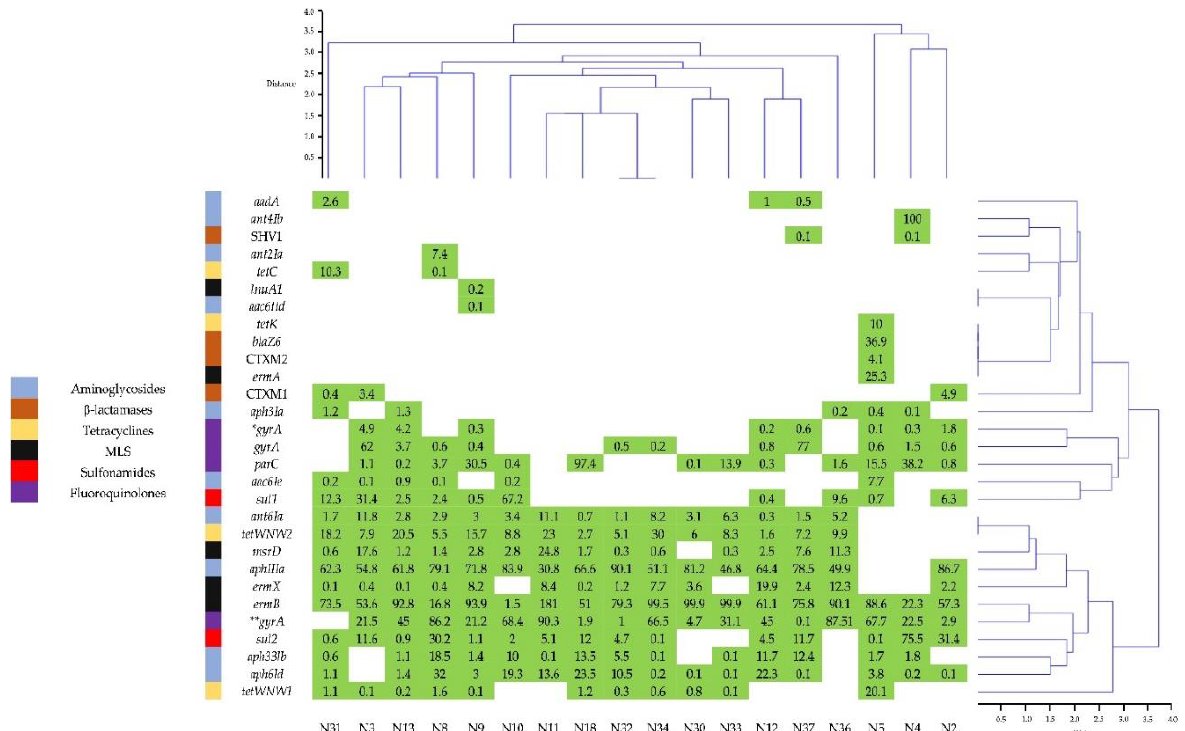
Figure 6. Presence of AMR genes in adolescent fecal samples. The numbers shaded in green indicate the presence of the particular gene, and the area in white indicates the absence of a gene. The samples and AMR genes are clustered in a similar way. * gyrA gene belong to the 259AAC allele, and ** gyrA belong to 247 TTG allele.